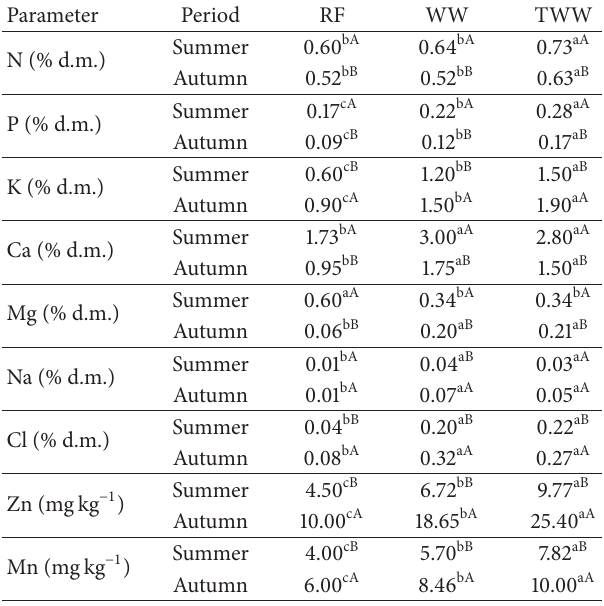
Small letters indicate significant differences ( 𝑃 ≤ 0.05 ) among treatments within each season according to LSD test. Capital letters indicate significant differences ( 𝑃 ≤ 0.05 ) among seasons within each treatment according to LSD